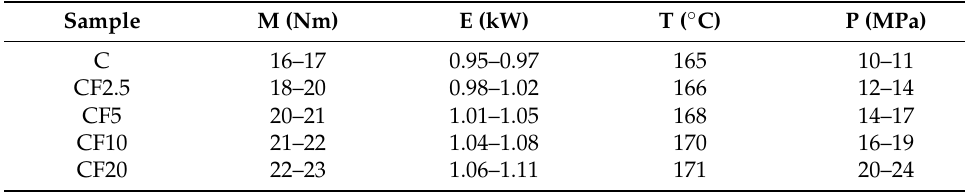
Table 1. The extrusion process parameters for PCL and its composites with HF.